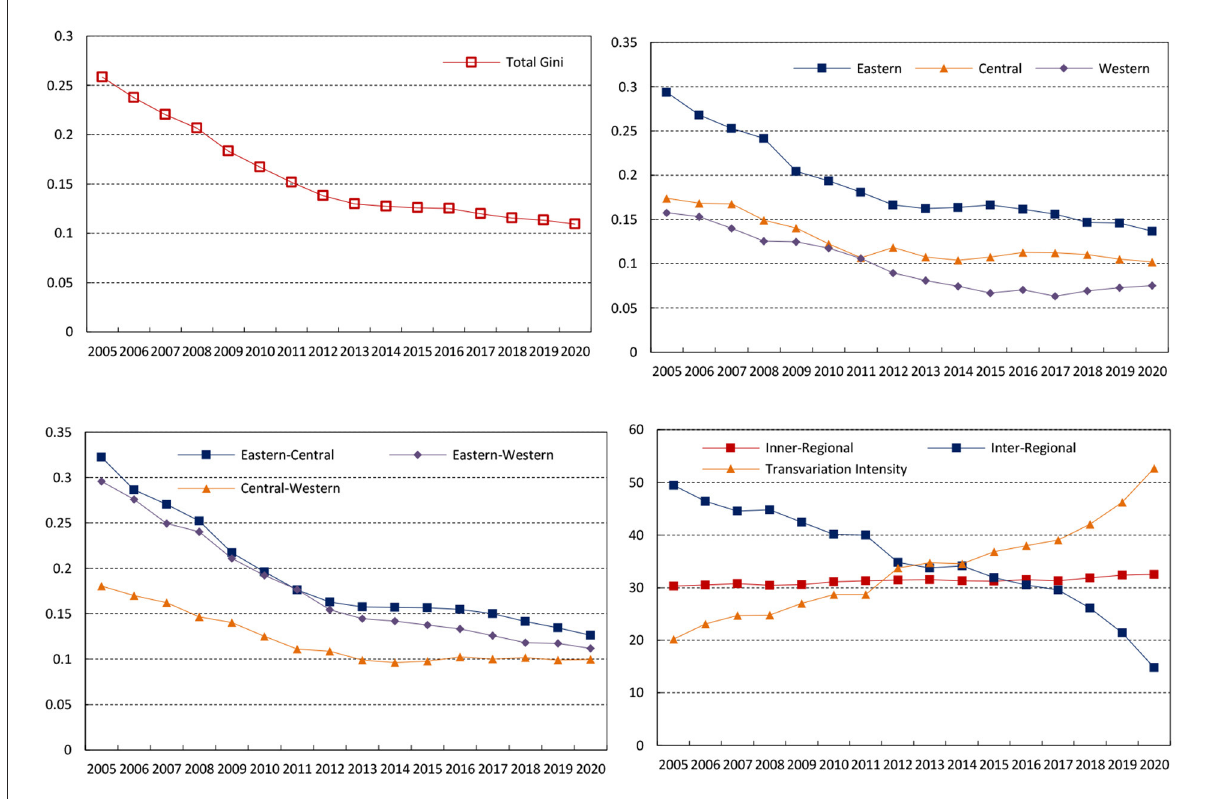
FIGURE6 Gini coefficient variation and differential contribution rate of the MHSS level in China.